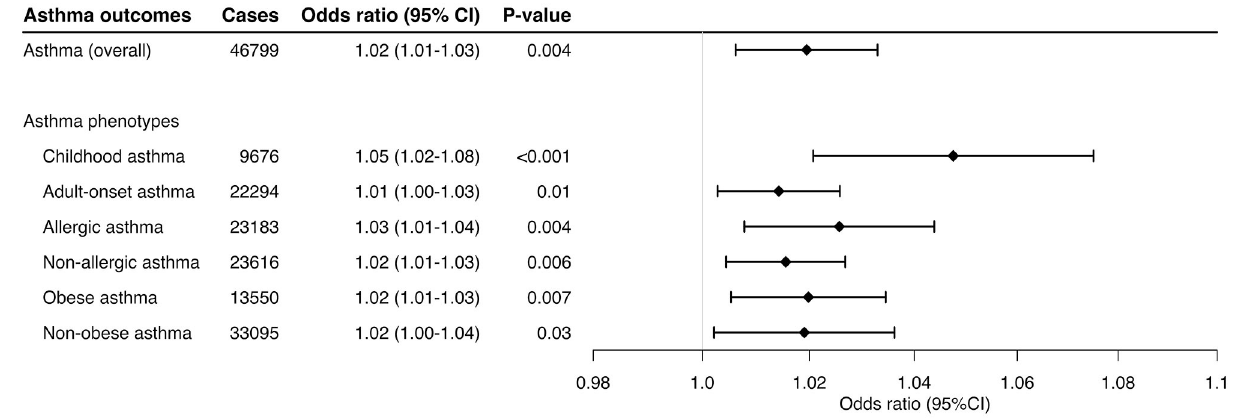
FIGURE 1 | Mendelian randomization estimates for the effect of soluble interleukin-6 receptors on overall asthma outcome. The size of the squares is proportional to the weight of the Mendelian randomization estimate for each variant, with the horizontal lines indicating their 95% confidence intervals. The center of the diamond represents the combined Mendelian randomization point estimate with the lateral tips indicating its 95% confidence interval, estimated by the inverse variance weighted method. The odds ratios were estimated per one standard deviation increment in the inverse-rank normalized sIL-6R level. CI, confidence interval; IVW, inverse variance